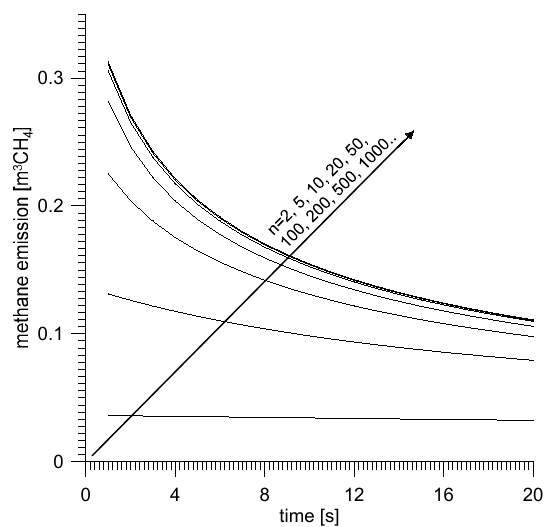
Figure 7. The influence of the number of terms in the series (9) on the quality of the reproduction of the first s of an outburst.